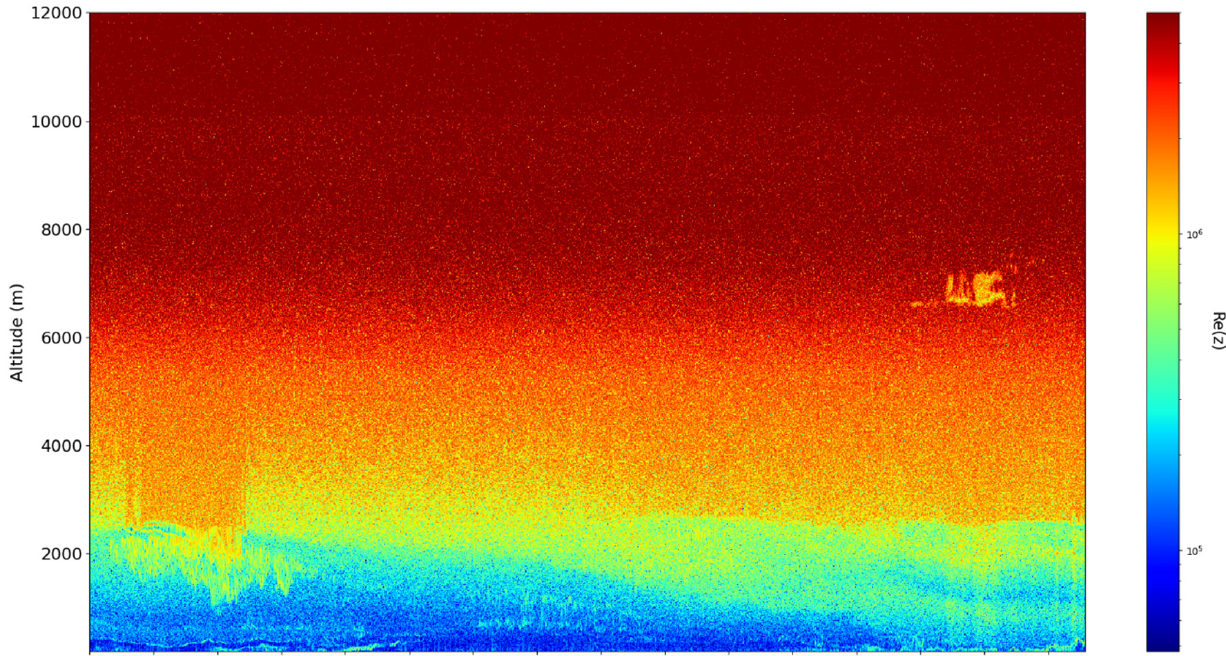
Figure 15. Re timeseries, λ = 1064 nm , Gala ț i, Romania, 22 December 2021.